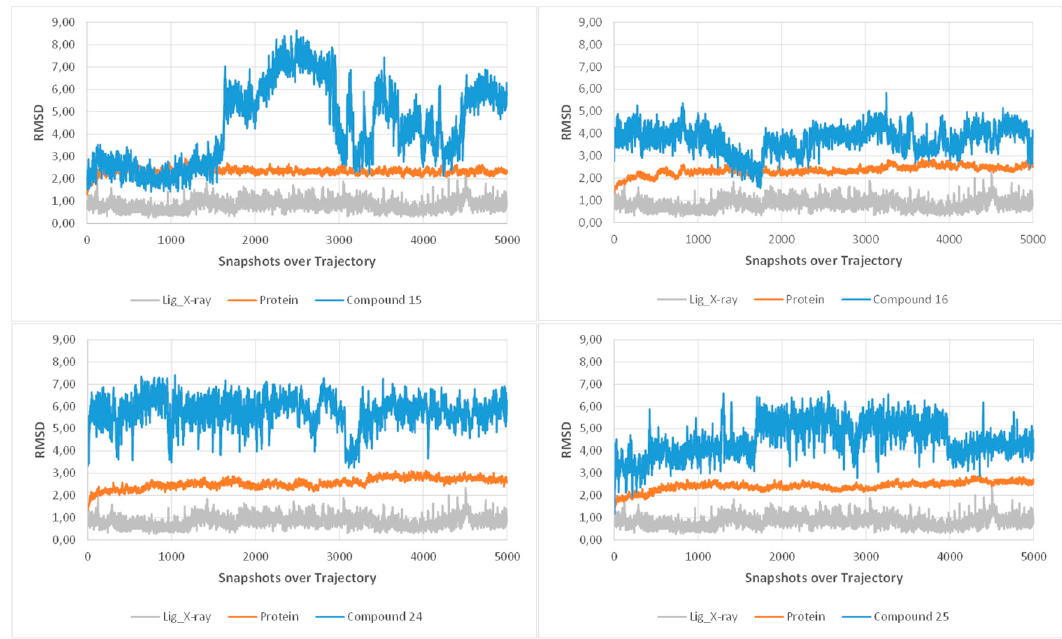
Figure 6. RMSD diagrams from the molecular dynamics simulations for each considered compound ( 15, 16, 24 and 25 ). The RMSD values over the trajectory are displayed in orange for the protein and in blue for the ligand. The RMSD values of the reference ligand from 4DXD structure are also displayed for information (data from an independent simulation).